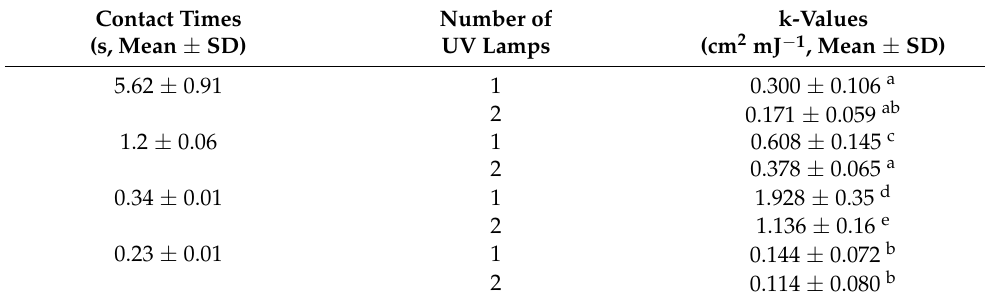
Table 4. K-values correspond to contact times and the number of UV